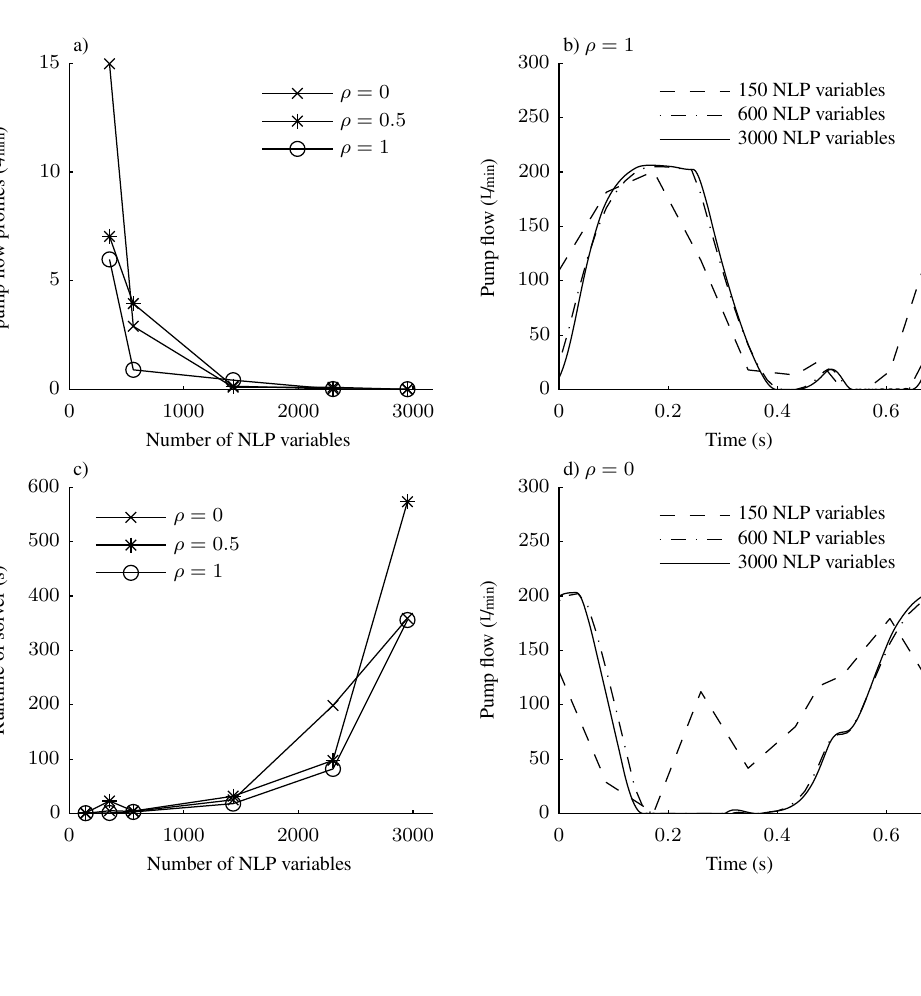
9.5 × 10 − 4 mmHg . The systemic arterial resistance imposed by the baroreflex mechanism is assumed to be constant for the OCP. Its value changed from 1 . 113 mmHg · s / mL for the constant pump-speed simulation to 1 . 110 mmHg · s / mL for the in vitro reproduction of the optimal solution. This difference of just − 0 . 27 % indicates that the use of the reduced model within the OCP is valid. The unavoidable modeling errors in Equation (4), as well as the tracking error of the pressure control system at the hybrid mock circulation led to differences between the optimized solution and the measured data, as shown in Figure 4. These effects accumulated to a reduction of the end-diastolic left ventricular volume from 133 mL to 128 mL and a reduction of the flow through the aortic valve from 1 . 08 L / min to 0 . 88 L / min . Figure 3. Convergence of the nonlinear program (NLP) solver for NLP Equation (9) and the resulting pump flow profiles. Panel ( a ) shows the RMS of the difference between a solution and the next finer discretized solution. Panel ( b ) shows the pump flow trajectories obtained for ρ = 1 and three differently accurate transcriptions. Panel ( c ) shows the runtime the NLP solver needs to converge, depending on the problem size. Panel ( d ) shows the same information as panel (b) for ρ = 0